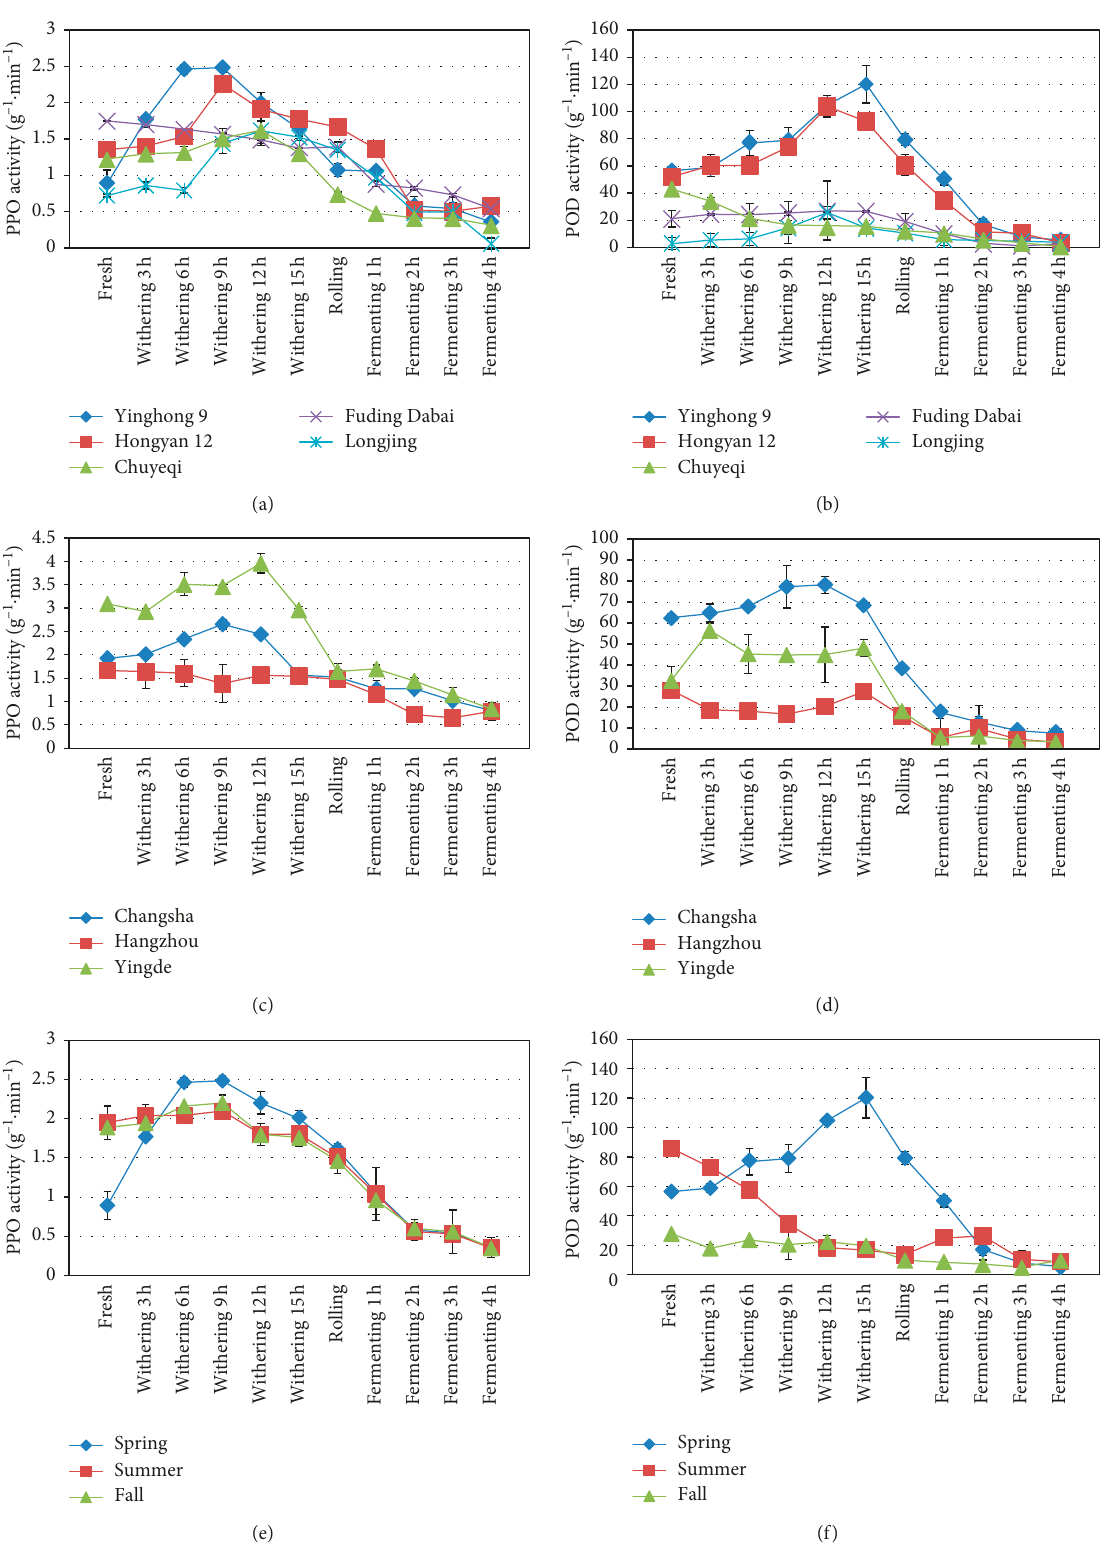
Figure 1: PPO and POD activities in fresh leaf cultivars during tea processing. (a, b) Different varieties; (c, d) different regions; (e, f) different